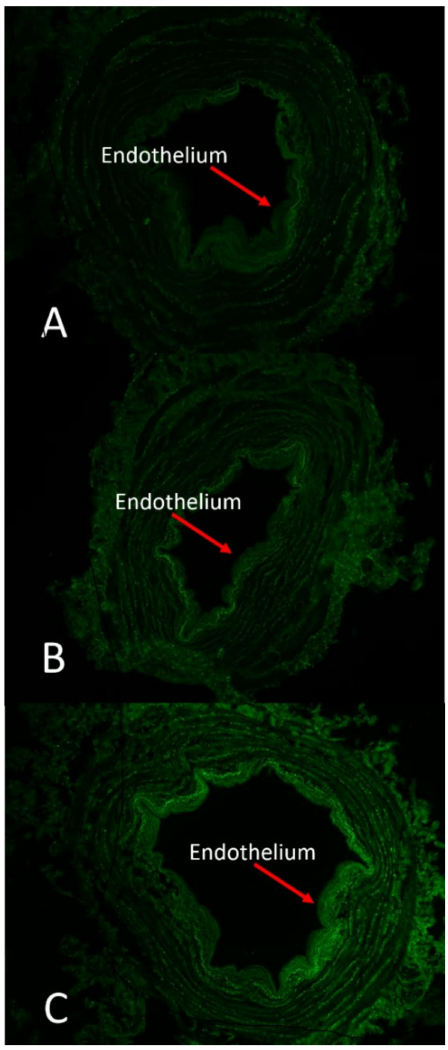
Figure 5. Changes in endothelial viability of vein segments stored in different preservation solutions. Vein segments were stored in Duragraft ( A ), autologous heparinized blood (AHB) ( B ) and physiolog- ical salt solution (PSS) ( C ) for 4 h after vein harvesting. The high green fluorescence indicates the apoptotic cells. At this incubation time, no differences were observed between the three intraoperative storage solutions regarding endothelial cell death. The test used measured the fragmented DNA of the apoptotic cells by catalytically incorporating fluorescein-12-dUTP(a) at the 3 (cid:48) -OH DNA ends. For this reason the test dis not discern between living and dead cells. Magnification